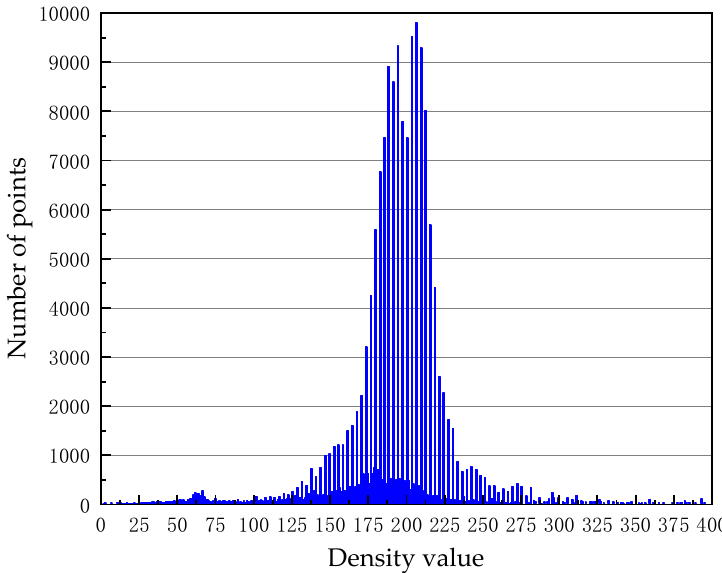
Figure 11. Density histogram of 100 m OCS point cloud. Take the smaller point cloud density of the data set as the minimum expected cluster.